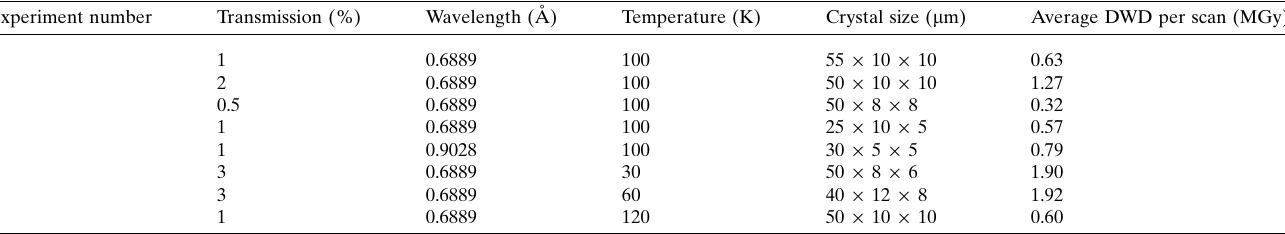
Table 2 Overview of experiments conducted in order to probe the effect of the parameters thought to be most influential in affecting radiation-damage